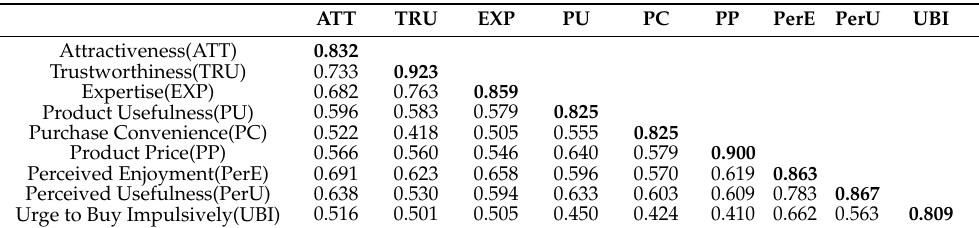
Table 3. Discriminant